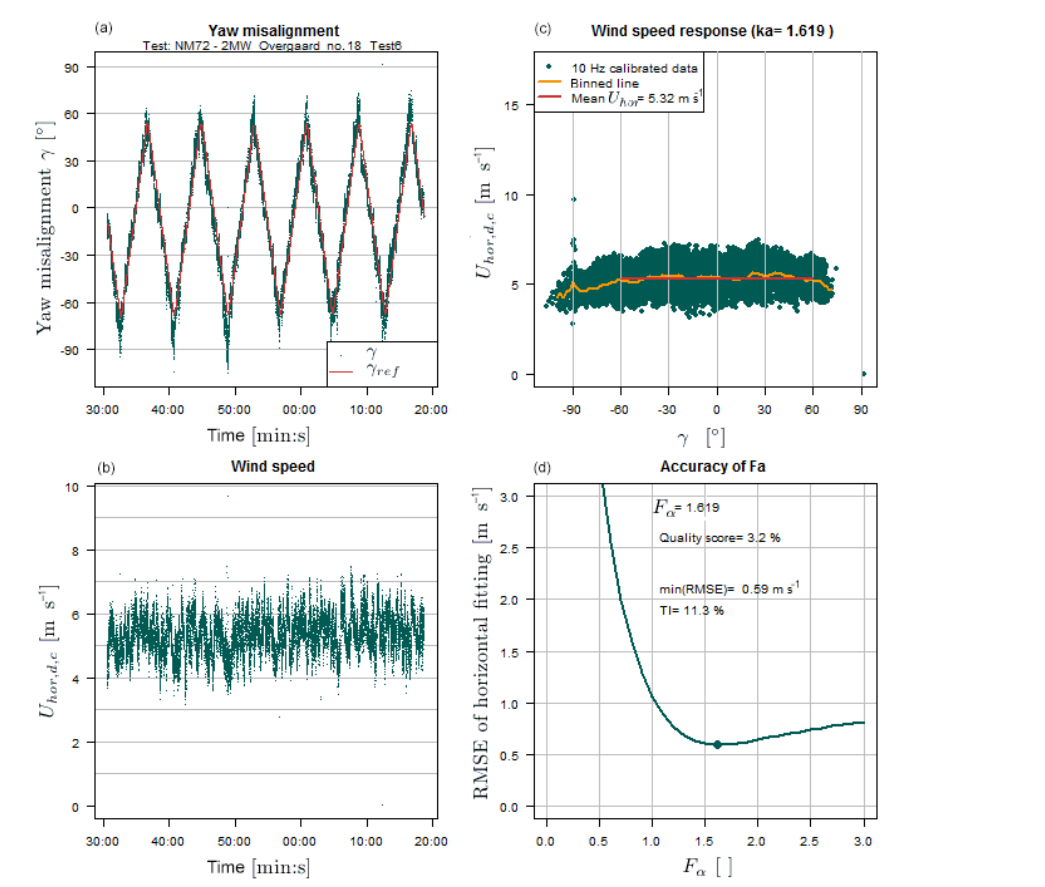
Figure 4. After calibration, test 6. (a) Time series of yaw misalignment as measured by the spinner anemometer and by the yaw position sensor. (b) Wind speed time series as measured by the spinner anemometer before F 1 calibration and after F α calibration. (c) Wind speed as a function of yaw misalignment both measured by spinner anemometer and calibrated with F α . (d) Root mean square error of the horizontal fit (red line in c ) as a function of F α